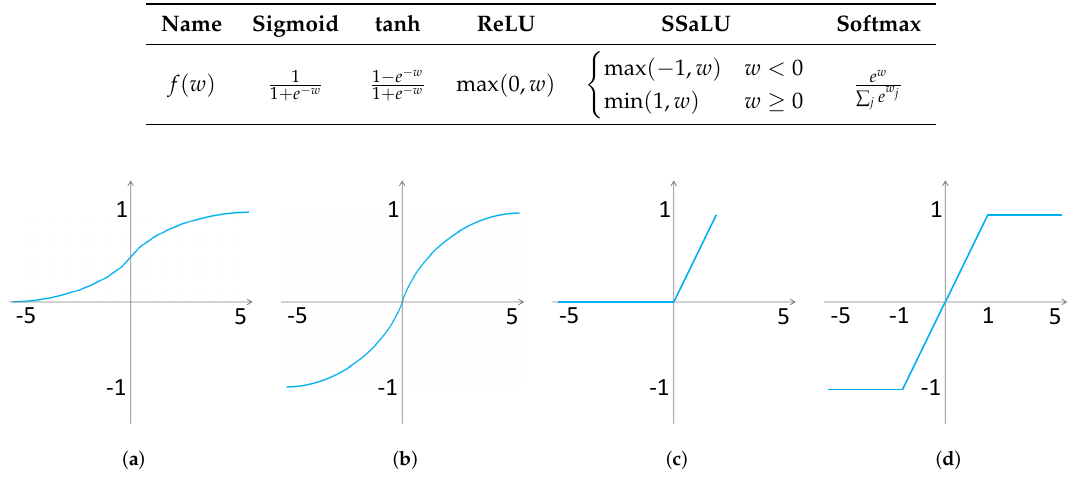
Figure 3. Illustration of activation functions.